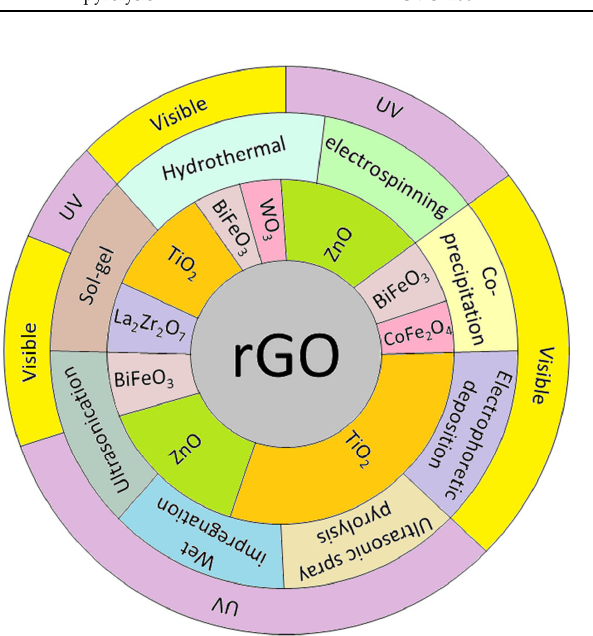
Figure 3. Illustration of various composites of rGO/semiconductors with their method of hybridization and suitable light energy represented from Table 2. In addition, the existence of rGO, as Prabhu et al. [110] stated in their work on ZnO/rGO nanocomposites, helps to shift the bandgap of UV light active to solar light ac ‐ tive semiconductors. Sharma and Lee [111] reported adding NiO to TiO 2 /rGO, resulting in a bathochromic change in the composite bandgap due to the interaction of Ti 4+ and Ni 2+ in the 3d level conduction band. In addition, rGO considered as an electron sink, which enhancing the photocatalytic activity of the composite and subsequently reduce the re ‐ combination rate of the photo ‐ induced electron ‐ hole pairs [112]. Several strategies, such as hydrothermal [26], ultrasonic [100], co ‐ precipitation [22], electrophoretic [105], sol ‐ gel [98], reflux column [113], electrospinning [108], ultrasonic spray pyrolysis [109], and wet impregnation [102], can be used to integrate rGO into sem ‐ iconductor photocatalysts. Some of the strategies are mentioned in Table 2 and addressed in the next subsection. In order to generate optimal photocatalysts, each technique has its parameters, such as temperature and time, to be considered. Variation of the nanocompo ‐ site morphologies observed with various integration strategies of semiconductors in the presence of rGO as depicted in Figure 4. It is crucial to note that the different morphologies produced by different techniques [27,95,98,103,105,108,109,114] will alter the bandgaps and other characteristics and lead to its performance reliability.